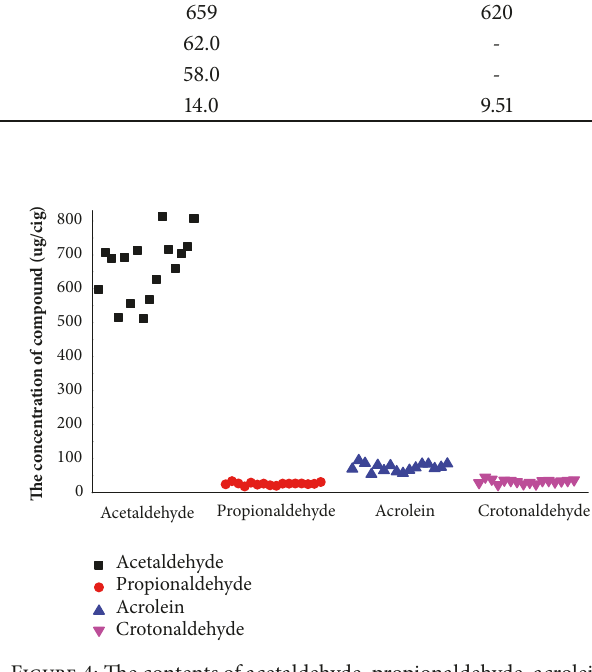
Figure 4: The contents of acetaldehyde, propionaldehyde, acrolein, and crotonaldehyde in gas phase of mainstream